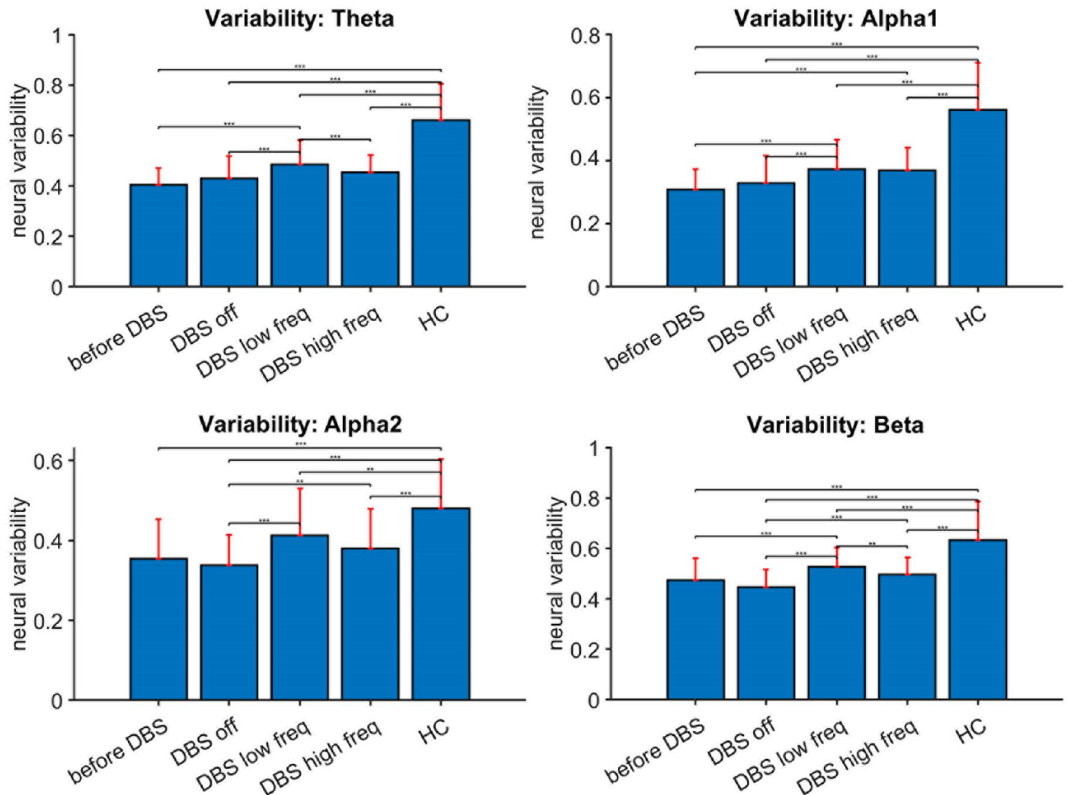
Figure 3. Neural variability for four different conditions in the patient, and for healthy controls (HC). Red bars: median values and interquartile range. Upper left: theta FC; upper right: alpha1 FC; lower left: alpha2 FC; lower right: beta FC. ** p < 0.01; *** p < 0.001. Also see Supplementary Material Fig. 3 for regional differences. Before DBS = before implantation DBS, DBS low freq = deep brain stimulation at 50 Hz/450 μsec, DBS high freq = deep brain stimulation at 130 Hz/60 μsec, DBS off = resting-state before